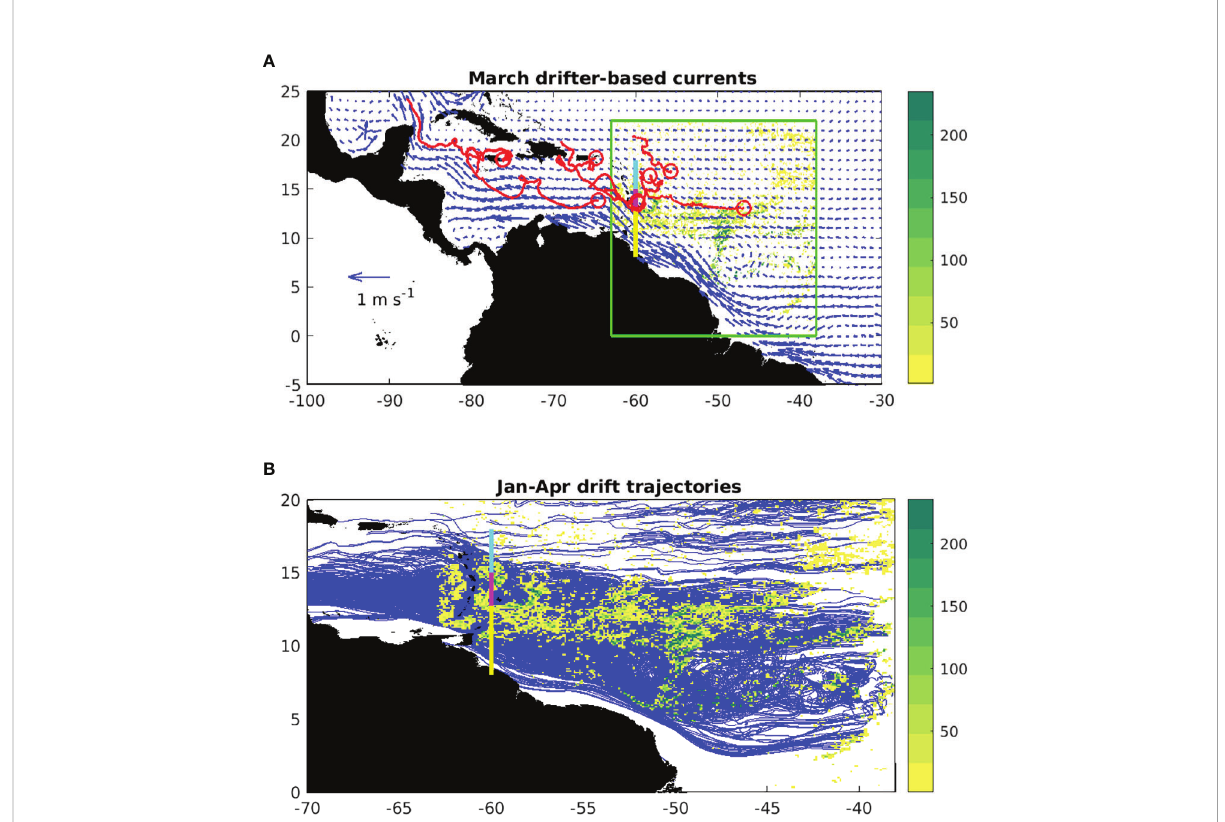
FIGURE 1 From the CERMES forecast system: (A) March surface currents inferred from GDP drift data, and nine example drift trajectories (in red, deployment locations indicated by circles) into and through the Caribbean, indicating the ‘ Central Atlantic ’ box (in green) for which week- averaged AFAI images are provided by SaWS, shown here for mid-March 2022 (non-dimensional units, colours); (B) Floating algae areal fraction from USF, observed by satellite for 12 January, from which 2188 trajectories are obtained (blue lines), each spanning 90 days. Also indicated in (A) and (B) are zones for forecasting sargassum fl uxes across 60°W ( ‘ South ’ , from the South American coast to 12.75°N, in yellow; ‘ Middle ’ , 12.75-15°N, in magenta; ‘ North ’ , 15-18°N, in